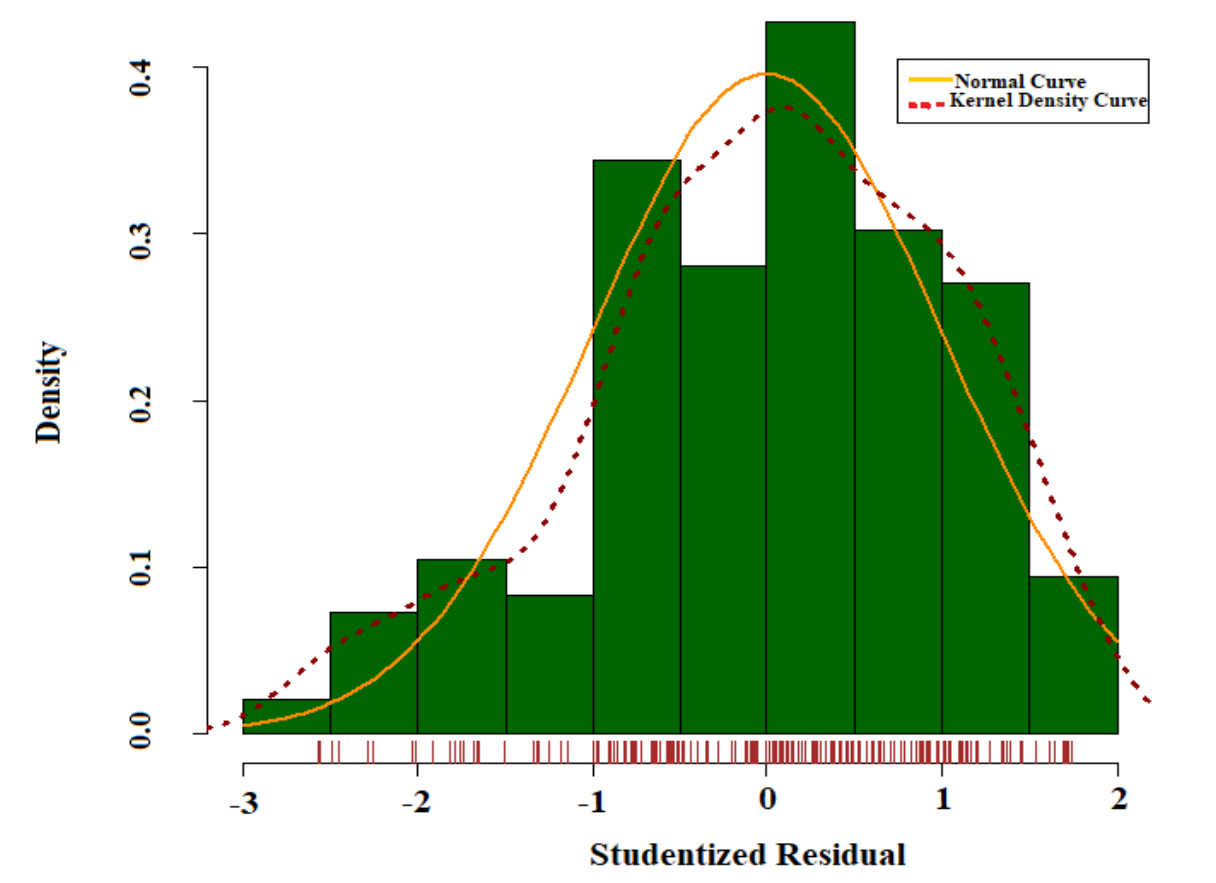
Figure 8. Normal distribution of residual value.